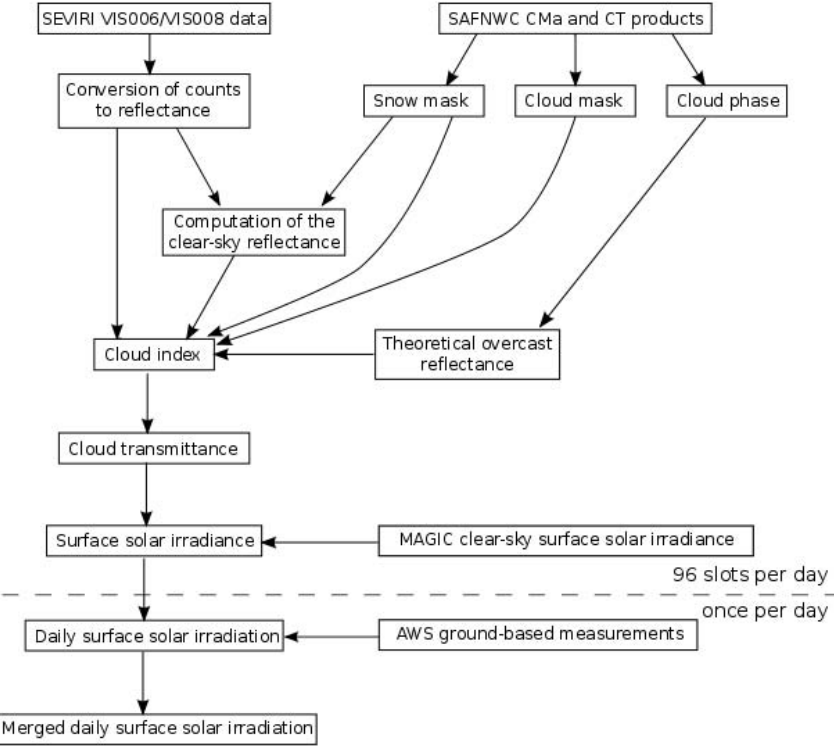
Figure 1. Schematic view of the MAGIC / Heliosat-2 process implemented at RMI.